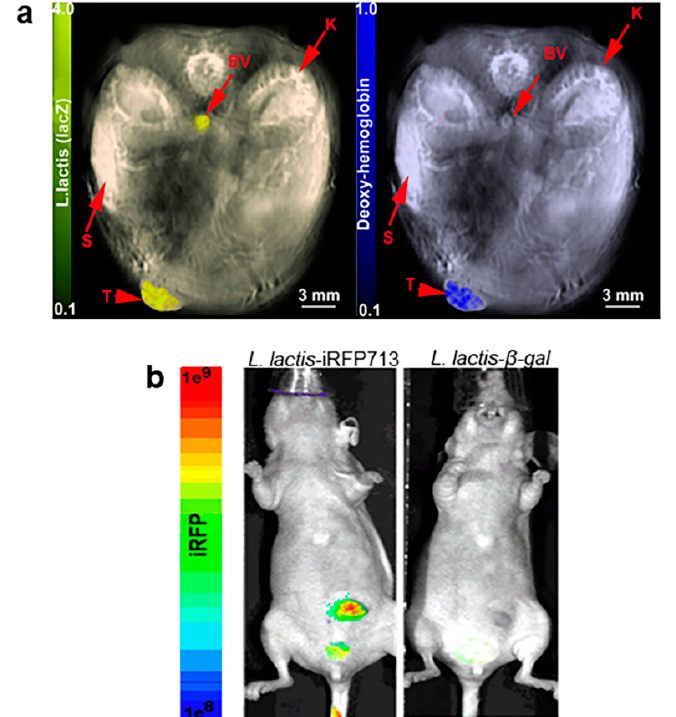
Figure 6. Feasibility of L. lactis- β -gal to establish within areas of tumor hypoxia using MSOT or near infrared imaging: ( a ) L. lactis- β -gal (1.5 × 10 9 CFU / 50 µ L) was i.v. injected into mice and detected within tumor. Mice were anesthetized using 0.1 L O 2 and 0.9 L medical air with 1.5% isoflurane for imaging following 24 h post-injection using MSOT. Mouse images were reconstructed and multispectrally processed using standard techniques. (Left) L. lactis - β -gal was demonstrated within the hypoxic regions of the tumor as depicted by deoxy-hemoglobin (Right). Organs are indicated using arrows: blood vessel (BV); kidney (K); spleen (S); tumor (T). ( b ) Feasibility of detection of L. lactis -IRFP713 using NIR fluorescence imaging. Mice i.v. injected with L. lactis -IRFP713 had identifiable signals (left), whereas the blue color-LacZ does not demonstrate fluorescent signals (right). A representative MSOT or NIR images at 24 h post-intravenous injection of L. lactis is shown from three preformed.